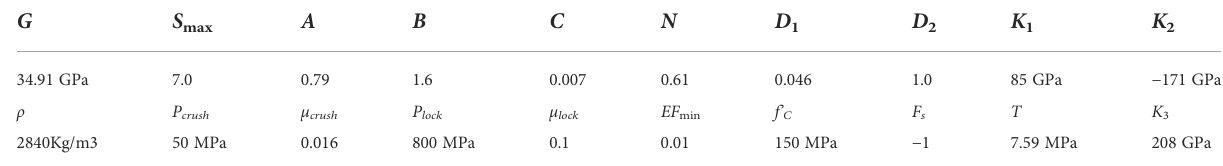
TABLE 1 Coal material